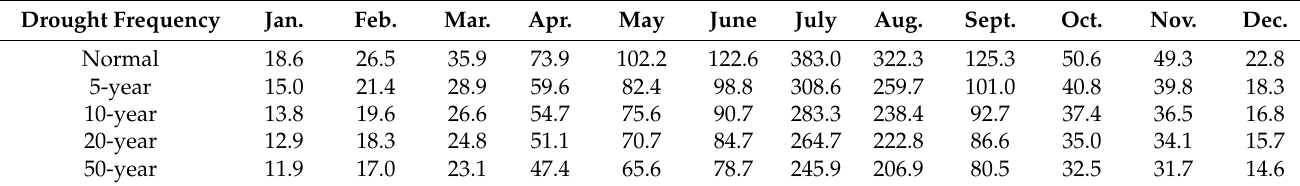
Table 2. Estimated monthly rainfall according to the drought frequency (unit: